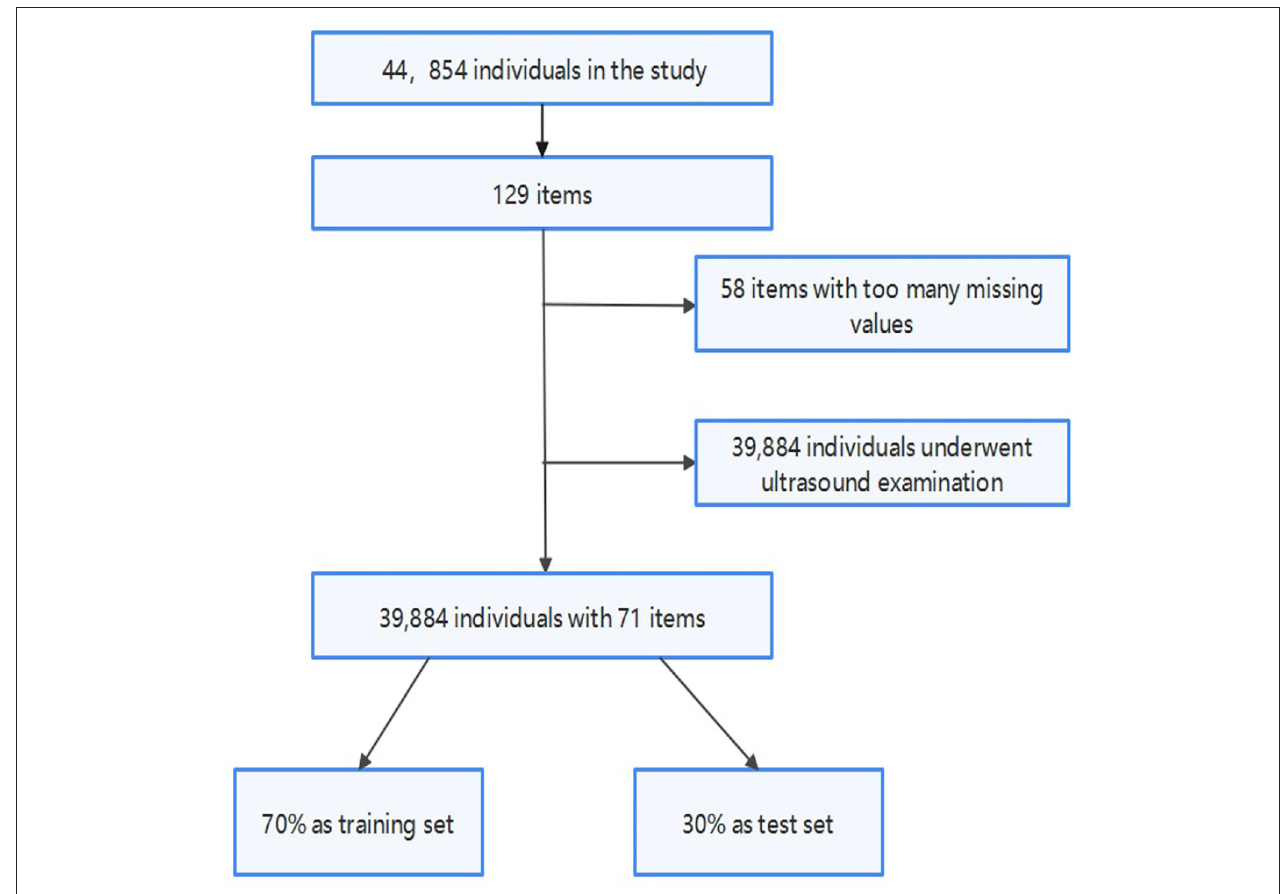
FIGURE 1 | Data preprocessing